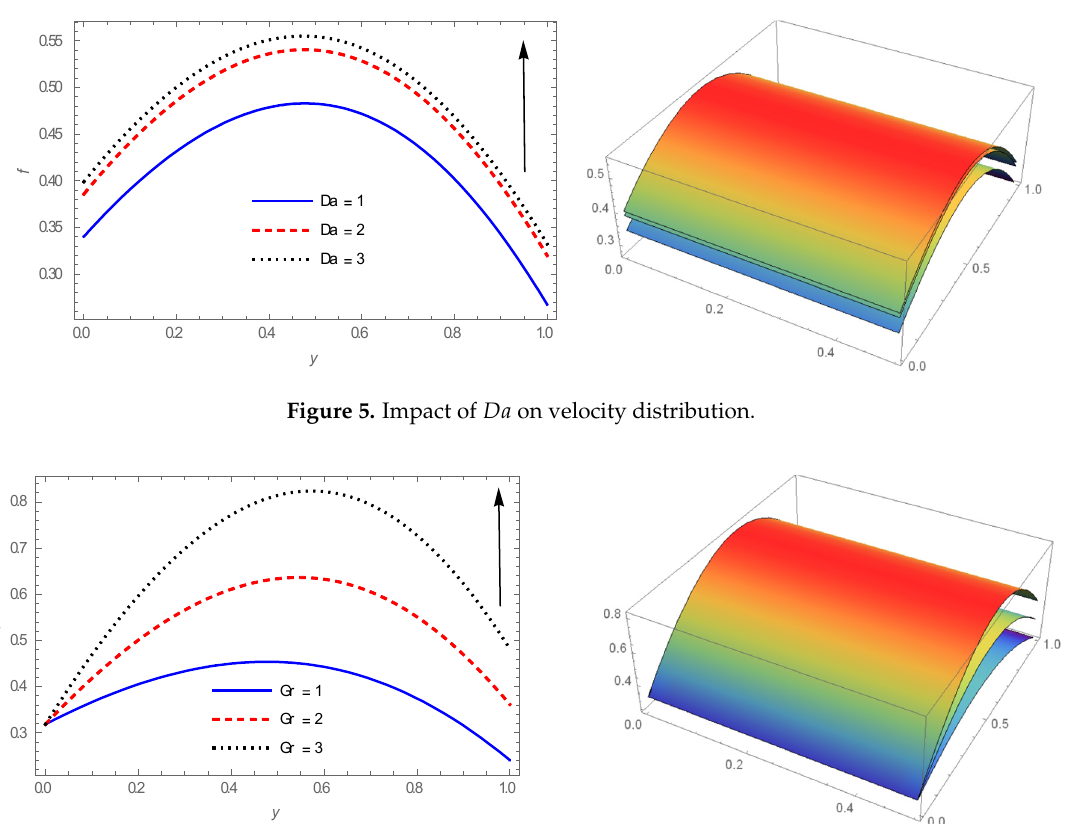
Figure 6. Impact of (cid:1833)(cid:1870) on velocity distribution.